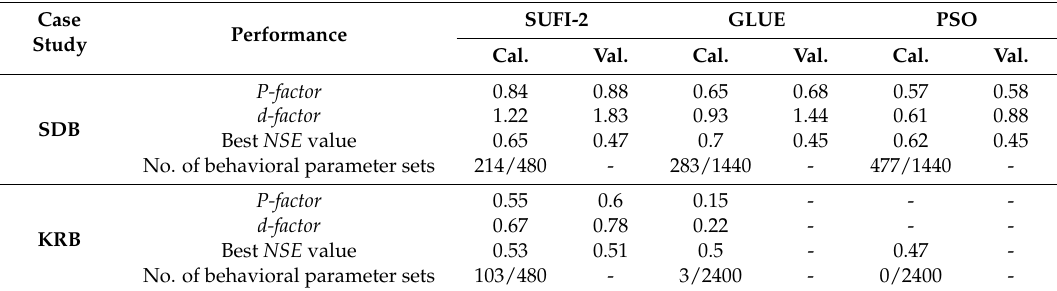
Table 8. Performance of the optimization algorithms and the number of behavioral parameter ranges for the calibration and/validation periods in Salman Dam Basin (SDB) and Karkheh River Basin (KRB). Case SUFI-2 Study Performance